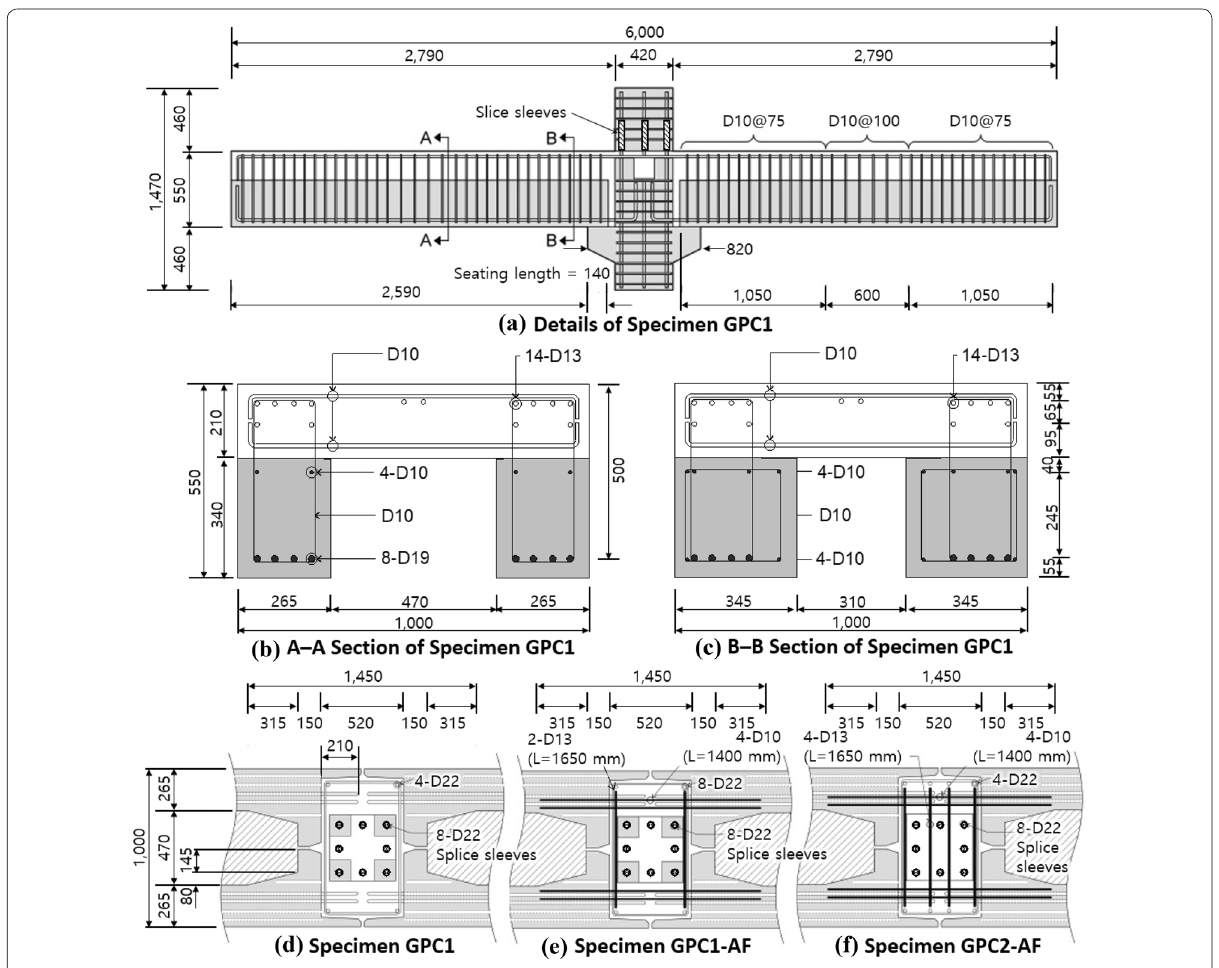
Fig. 7 Configuration and reinforcement details of test specimen under gravity